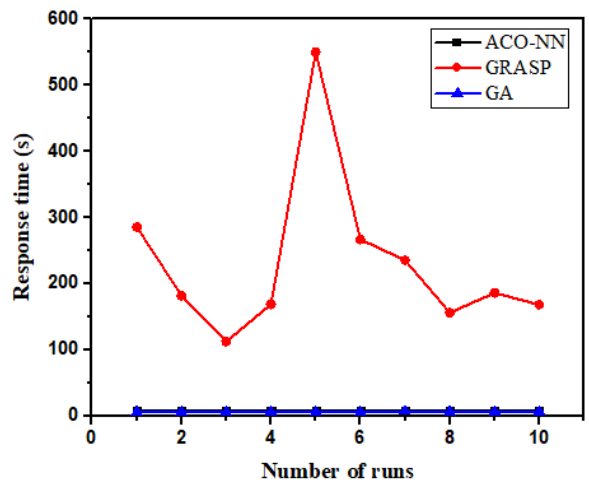
Figure 12. Results of response time vs. number of runs for KroC100.